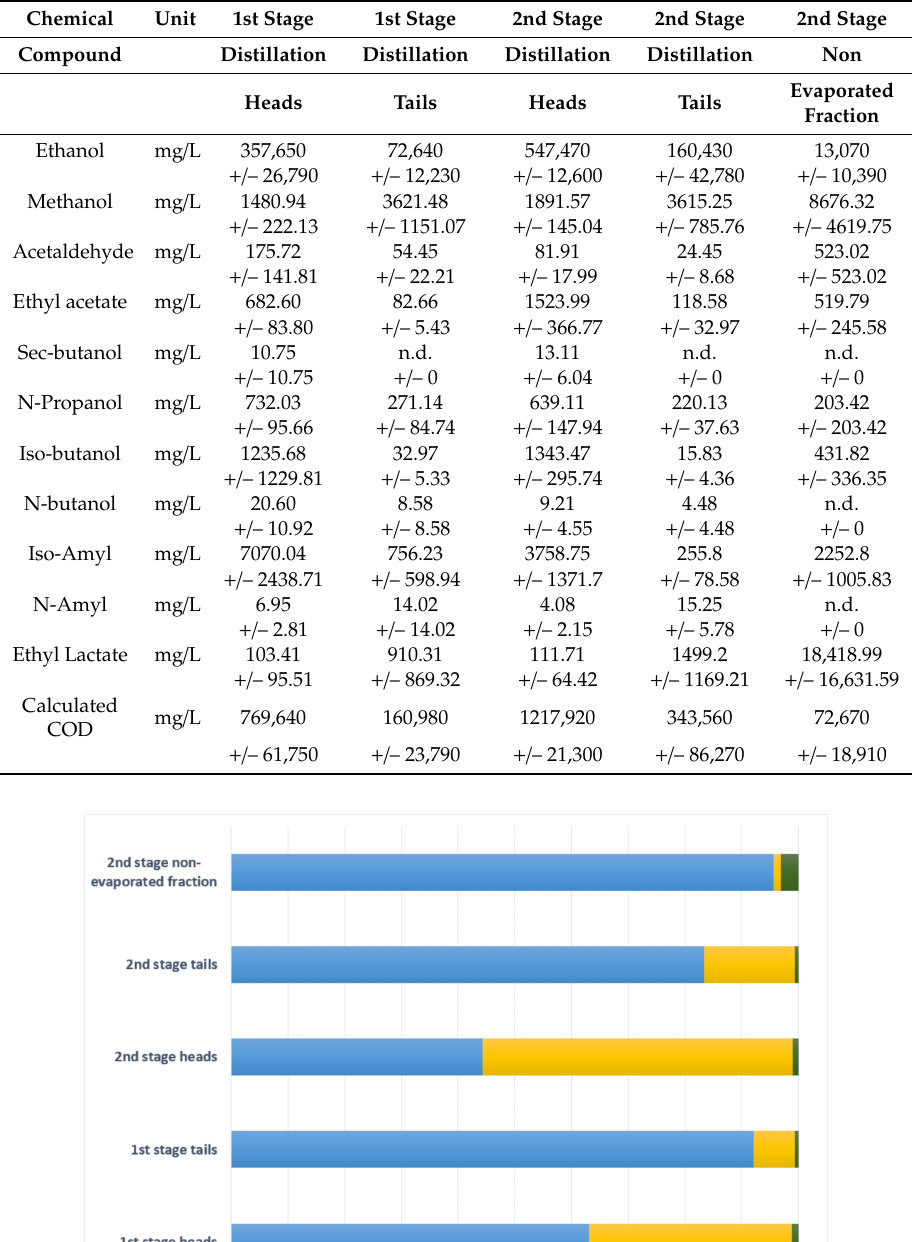
Table 3. Chemical composition and calculated COD.